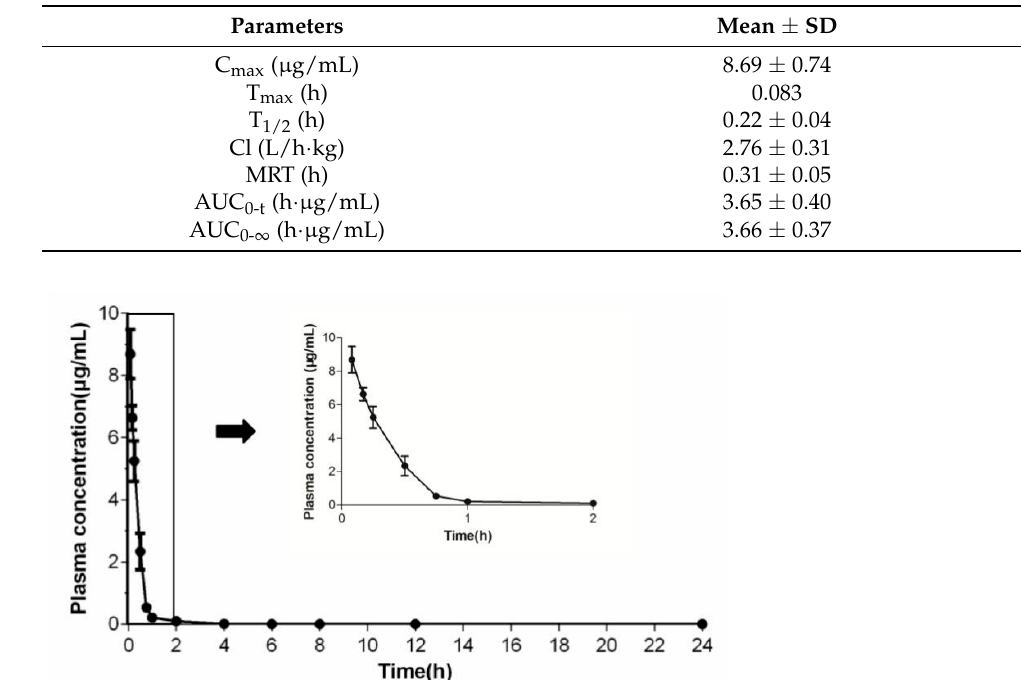
Table 4. The non-compartmental parameters of NPDM. (C max , maximum concentration; T max , time to reach C max ; T 1/2 , half-life; CL, clearance; MRT, mean resident time; AUC 0 → t , area under the curve from zero to the last measurable plasma concentration; AUC 0 → ∞ , area under the curve from the last measurable plasma concentration to infinity).